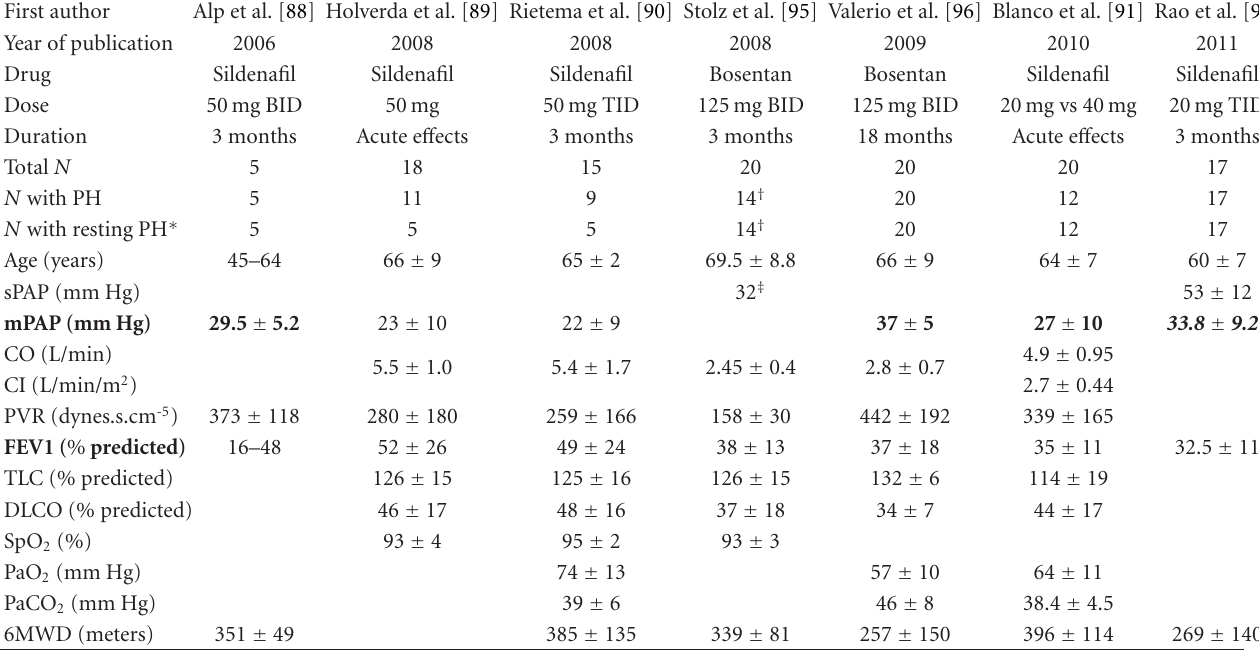
Table 7: Baseline characteristics of the patients who received pulmonary vasodilators in the published studies of such drugs in